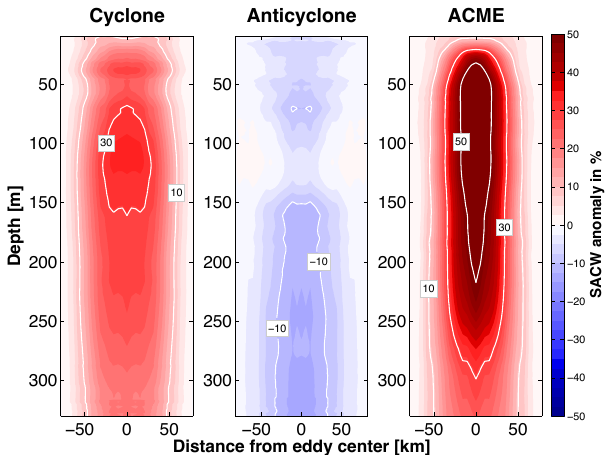
Figure 15. Vertical sections of SACW anomaly through the center of the composite cyclone (left), anticyclone (middle), and ACME (right) in the